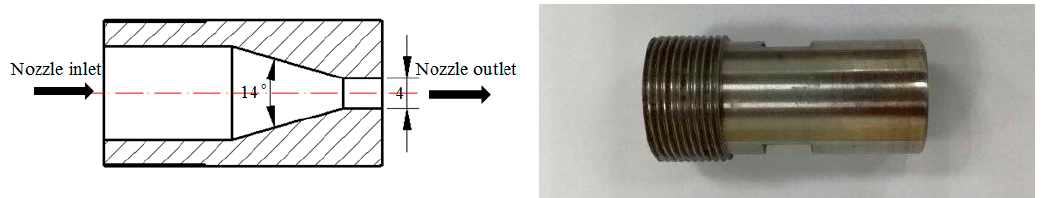
Figure 2. Profile and photo of nozzle.